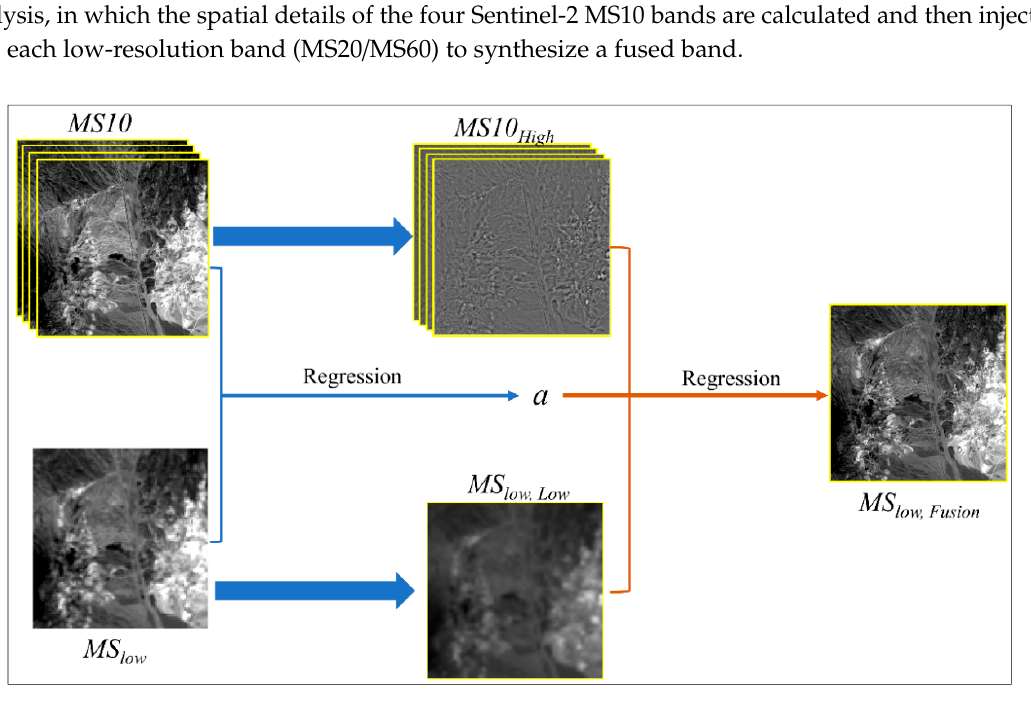
Figure 1. Flowchart of the multivariate (MV) method for Sentinel-2 image fusion. MS10 are the four original 10 m MS bands; MS10 High are the spatial details of 10 m band MS10 ; MS low is the original 20 m / 60 m MS band; MS low,L is the approximation with a pixel size of 20 × 2 m (60 × 2 m), which has a spatial resolution of 20 m (60 m); and MS low,F is the fused MS20 / MS60 bands with a pixel size of 10 m.